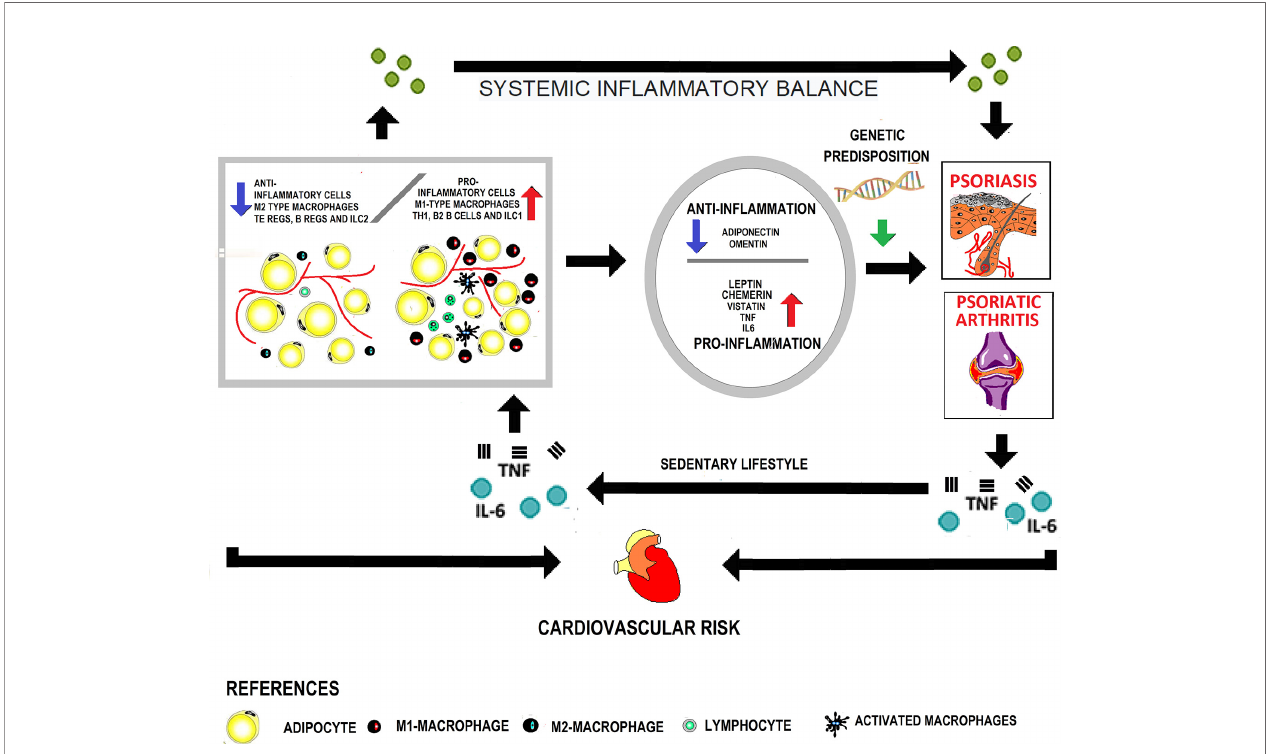
FIGURE 1 | Interaction between obesity and adipokines in the development of psoriasis, psoriatic arthritis, and cardiovascular disease. In obese patients, the adipose tissue presents cellular changes due to greater in fi ltration of pro-in fl ammatory cells with a decrease in the anti-in fl ammatory cell population. In this way, it becomes dysfunctional and acts as an endocrine organ, increasing the secretion of pro-in fl ammatory adipokines. A systemic in fl ammatory state is generated that, in genetically predisposed subjects, favors the appearance of skin psoriasis. On the other hand, the increased mechanical load at the enthesis sites contributes to the onset of psoriatic arthritis. The in fl ammation characteristic of the disease added to the sedentary lifestyle secondary to joint involvement perpetuates the growth of adipose tissue. Finally, both due to the presence of classical and non-classical factors associated with obesity, cardiovascular risk